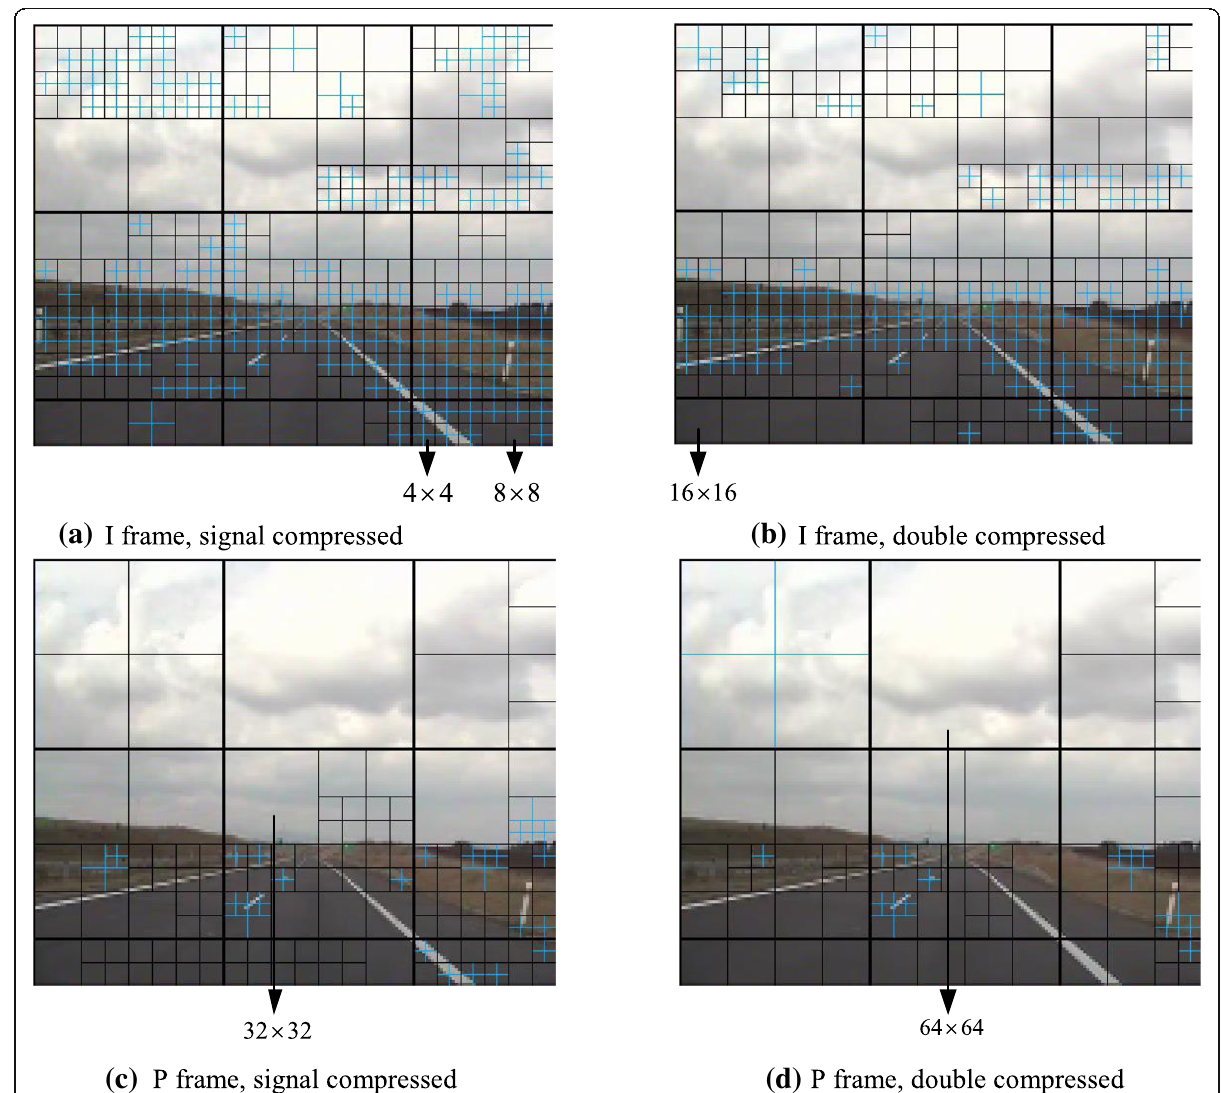
Fig. 4 a – d Example of TU partition type in the first I frame and the first P frame of a GOP in a single compressed video and its corresponding double compressed